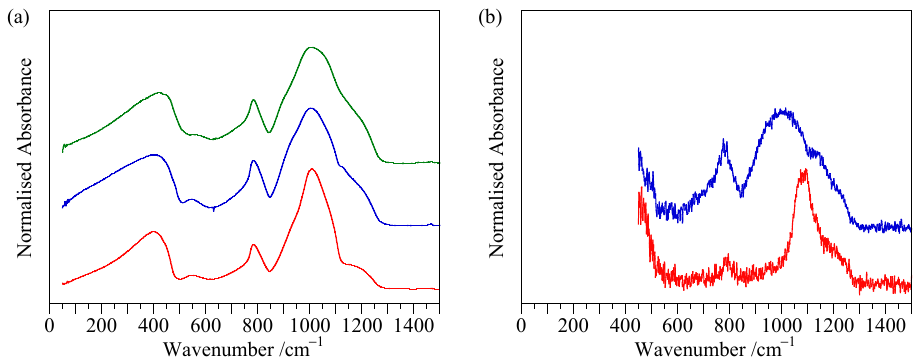
Figure 14. Further examples of flat sample ATR spectra: ( a ) opal-AG gems recorded on Bruker v80 instrument: (red) facetted Australian jelly opal, (blue) polished Australian jelly opal, and (green) cabuchon from Ethiopia. ( b ) Untreated opal-CT recorded on Nicolet Nexus 8700: (red) G32226 from St Austell, England, and (blue) G32925 from Tselinograd, Qazaqstan. Spectra are offset and scaled for convenience and corrected for ATR depth penetration.